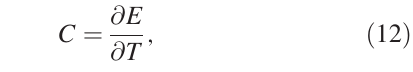
CDMFT (squares) for two different temperatures (left-hand panels, imaginary part; right-hand panels, real part). The results of the calculations from both methods agree within error bars for both local and NN components.